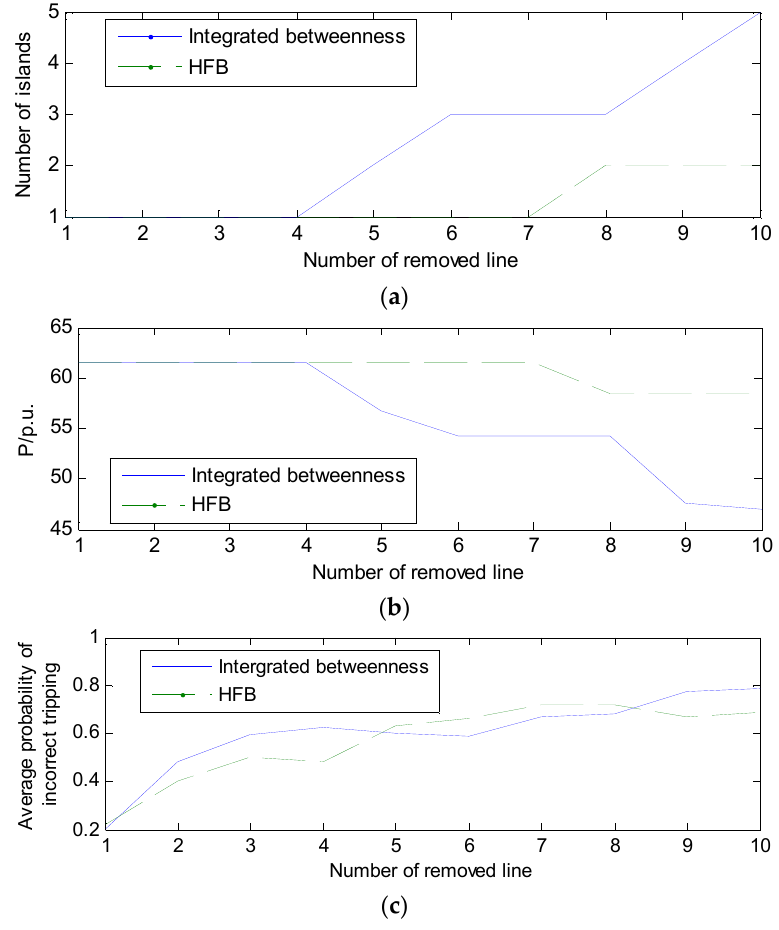
Figure 7. ( a ) The number of the islands under the attacks on the first ten critical lines; ( b ) the total value of the loads under the attacks on the first ten critical lines; and, ( c ) the average probability of the incorrect tripping of remaining transmission lines under the attacks on the first ten critical lines.